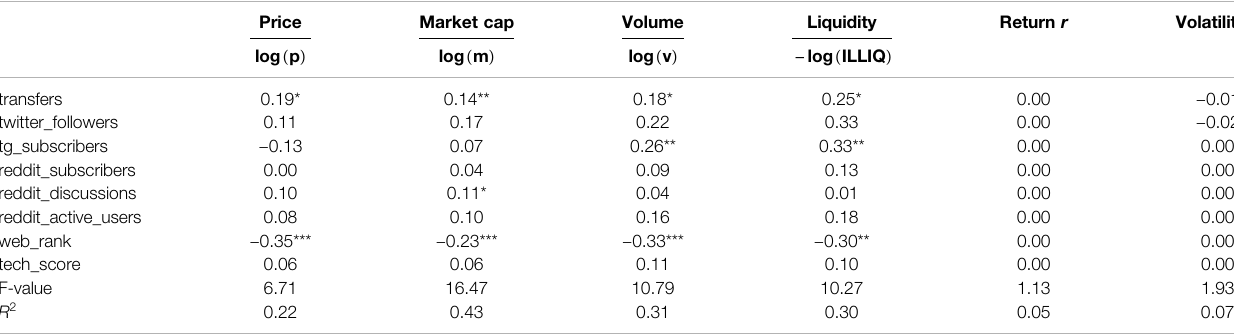
TABLE 3 | Regressions between the market indicators and the control variables (model 1).